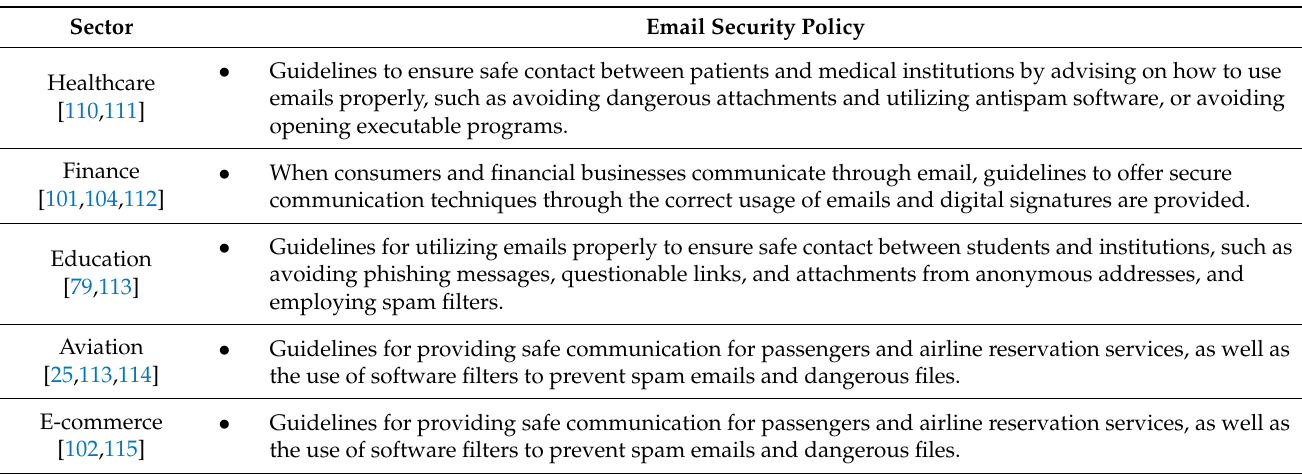
Table 5. Email security policy among different